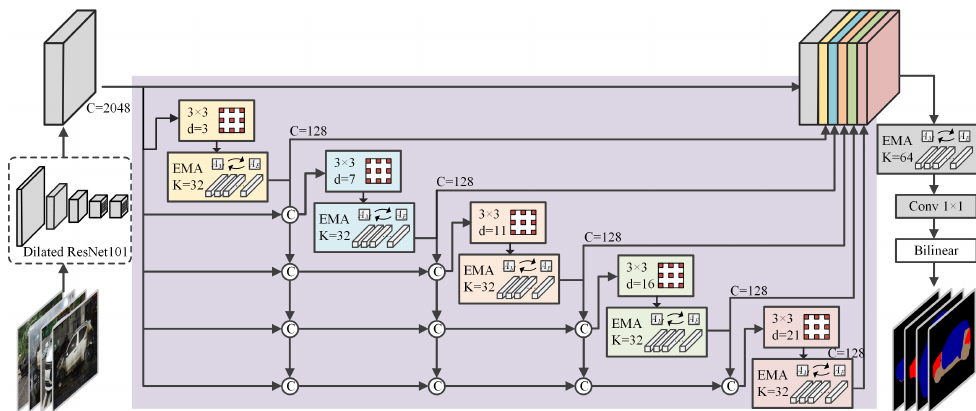
Figure 4. Structure of the severity segmentation branch. C is the output channels, K is number of bases contained in the EMA unit, and d is the dilation